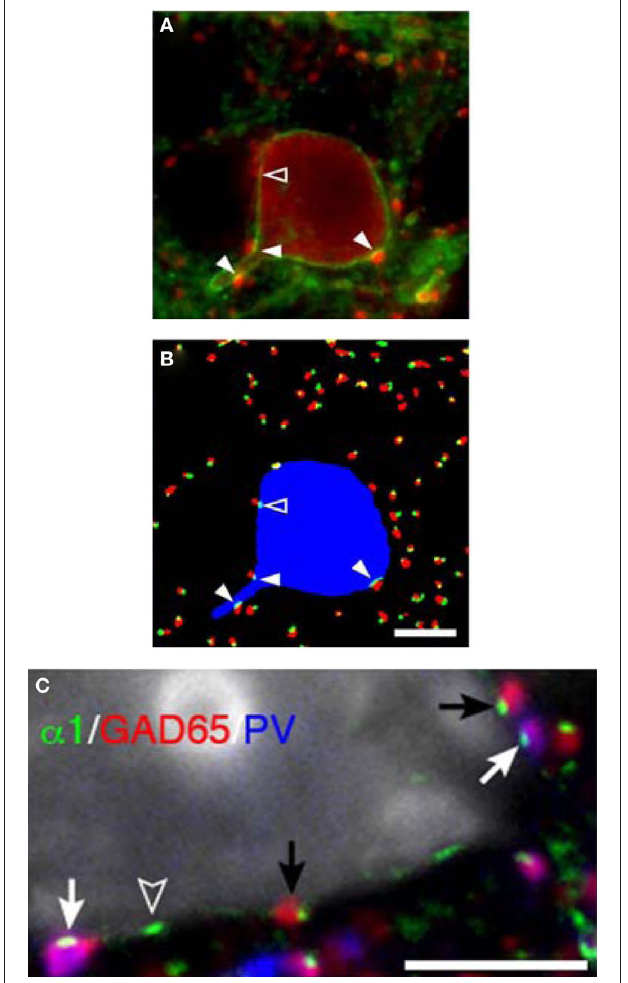
Figure 6 | Parvalbumin-positive basket cell boutons apposing gABA α A 1 subunits in the plasma membrane of neurons. (A) In a single confocal z -plane GABA (green) is seen in the plasma membrane of a PV (red) neuron α A 1 in a tissue section. (B) Color segmentation masks of the image in (A) which represents the intracellular PV (blue), PV boutons (red) and GABA clusters α A 1 (green). The different masks were made using different parameters for our iterative approach. Only the red and green object masks that partially overlap, and thus correspond to PV puncta and α 1 clusters that are directly apposed, are shown. The arrowheads point to α 1 clusters that are within the PV neuron and are directly apposed by PV puncta. Note that in (A) several PV puncta appear to juxtapose the soma near the open arrowhead. However, in this z -plane only one is directly apposed to an α 1 cluster (open arrowhead). (C) A single confocal z -plane of a tissue section was labeled for GABA subunit α A 1 Figure 7 | Low power confocal XY montage of human primary auditory (green), GAD65 (red), PV (blue), and Nissl substance (gray). Note GAD65 and cortex. (A) Immunoreactivity for VGlut1 demonstrates intense label of the PV dual-labeled (purple) boutons (white arrows) and GAD65 labeled boutons entire gray matter, consistent with localization in boutons of cortical origin. (black arrows) in apposition to GABA subunits in the plasma membrane of a α A 1 (B) VGlut2 labels boutons in the thalamic termination zone in layer 4 and deep pyramidal cell. The open arrowhead indicates an α cluster for which the 1 layer 3. Bar = 150 apposed bouton is below the plane of focus. All Bars = 5 μm.